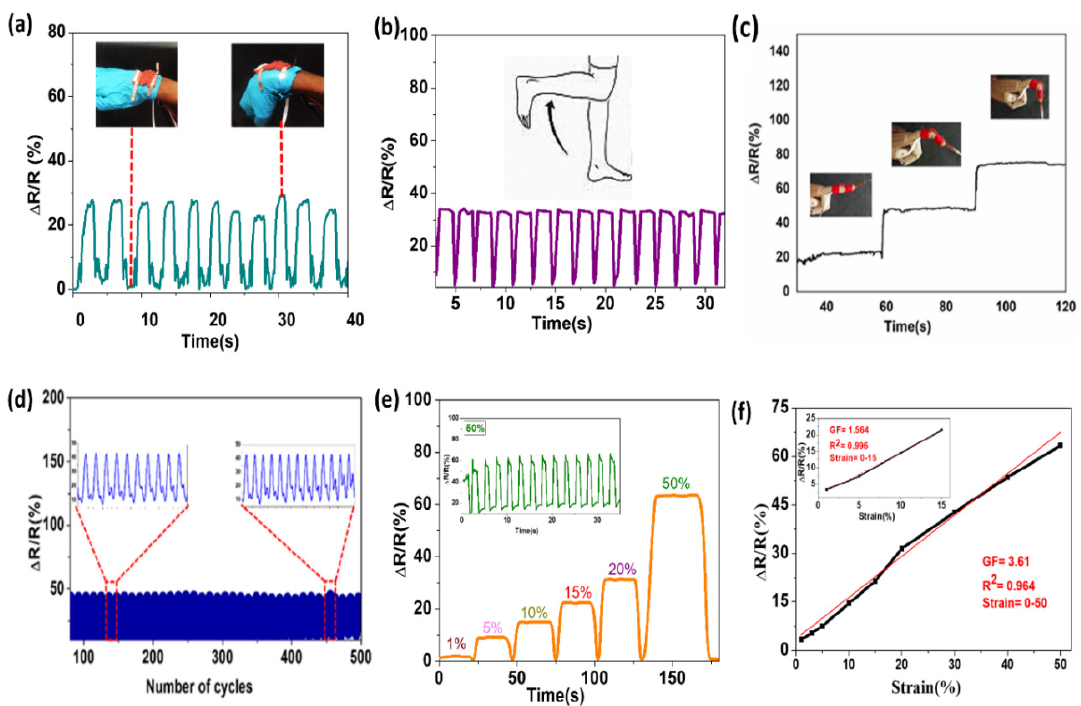
Figure 10. Applications of conductive purl fabric: ( a ) wrist bending, ( b ) knee bending, ( c ) finger bending at different degrees, ( d ) repeated cycle of strain force under 30%, ( e ) strain force at 1%, 5%, 10%, 15%, 20%, and 50%, and ( f ) gauge factor of purl fabric.